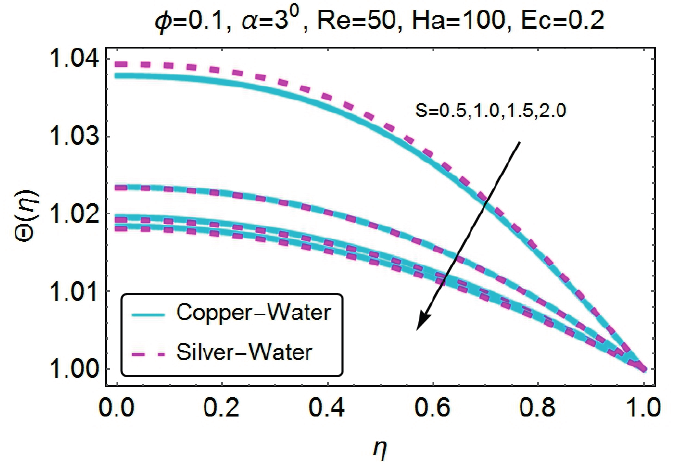
Figure 20. Change in temperature for varying S (divergent channel/stretching case).